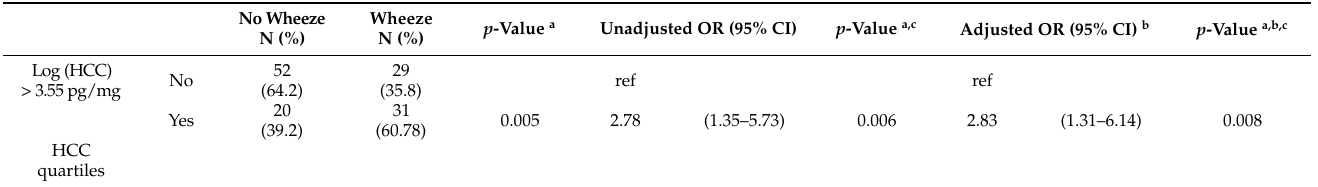
Table 2. Maternal hair cortisol and childhood